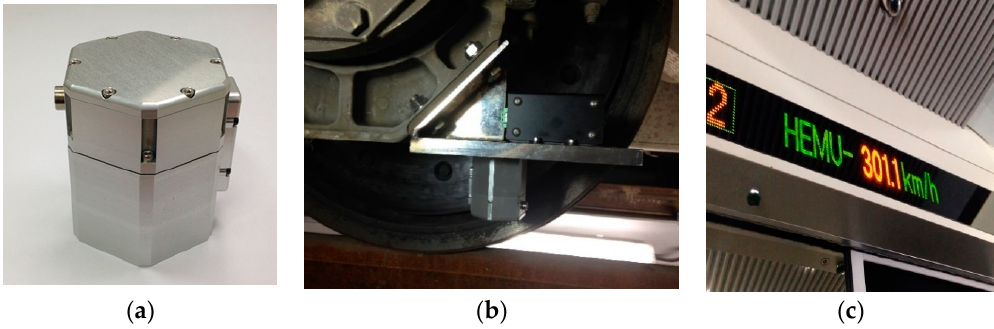
Figure 2. The VEH device with the protecting case ( a ), the VEH device for the high-speed train test on the axle box ( b ), the test speed example of the high-speed train during the VEH device test: 301.1 km/h ( c ).